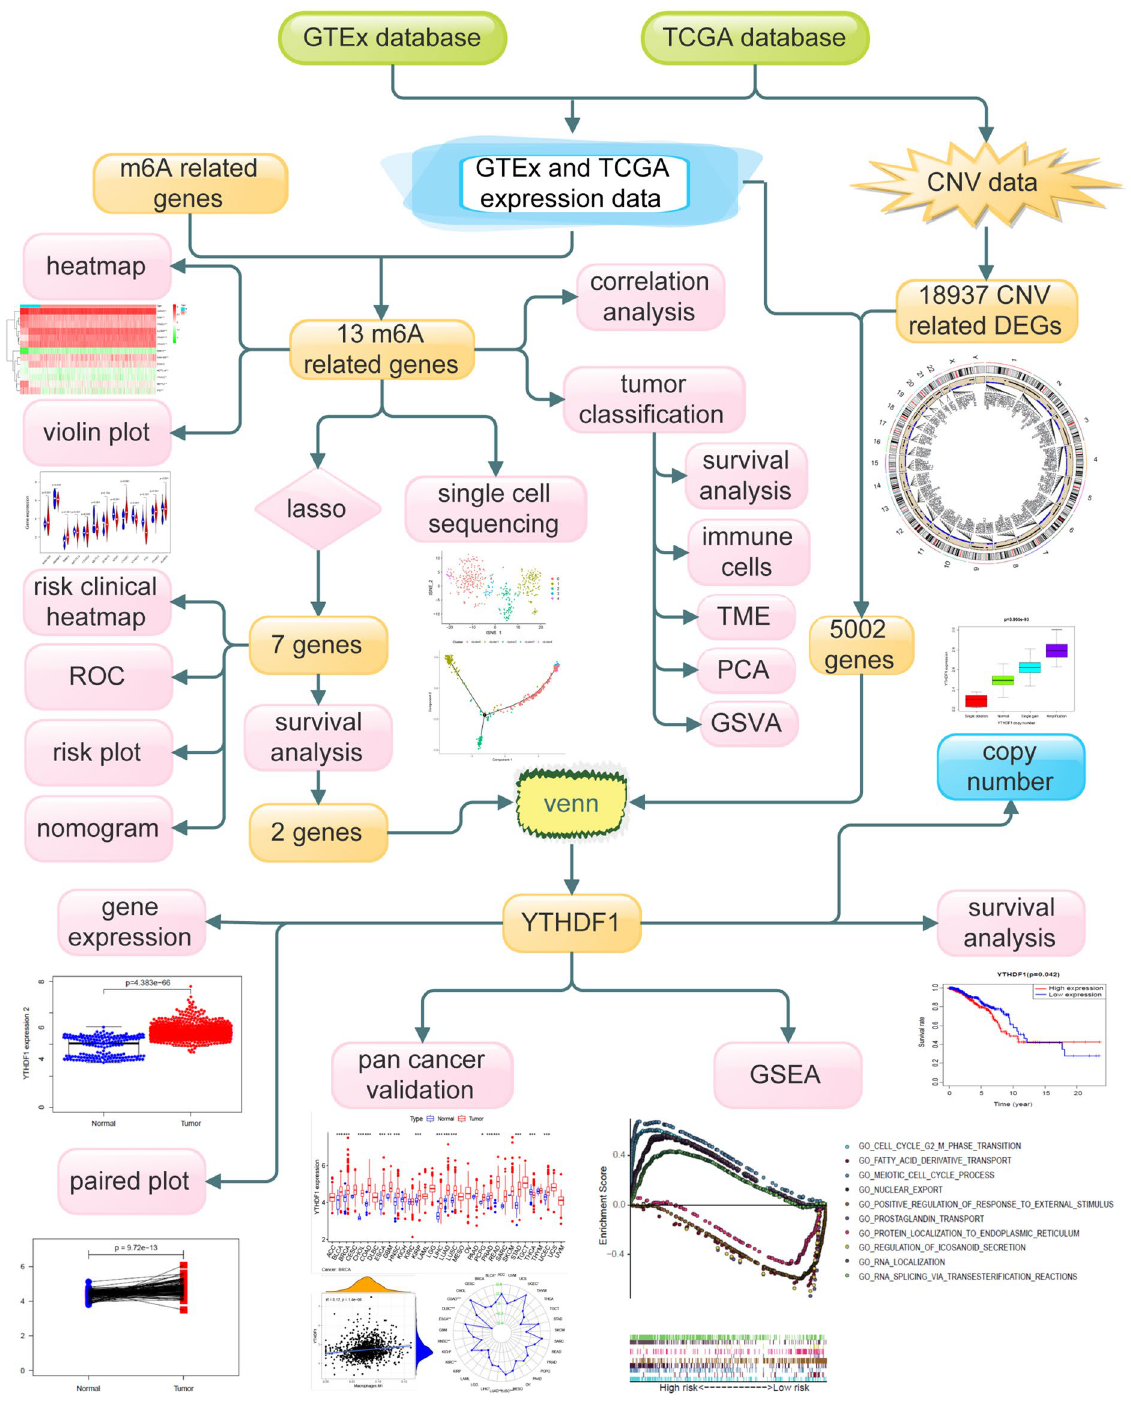
Figure 1. A flowchart showing the steps in this